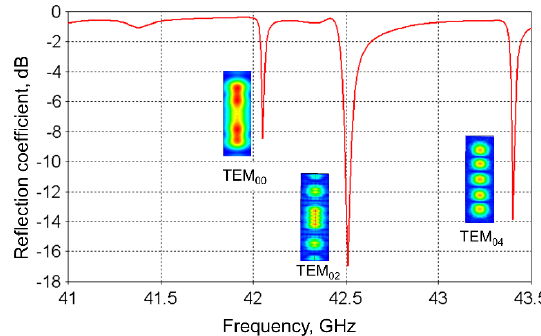
Figure 3. Simulated reflection coefficient of the open resonance structure connected to the microwave waveguide. The correspond- ing resonance modes are identified by calculation of the B 1 field distribution at the plain mirror (shown as